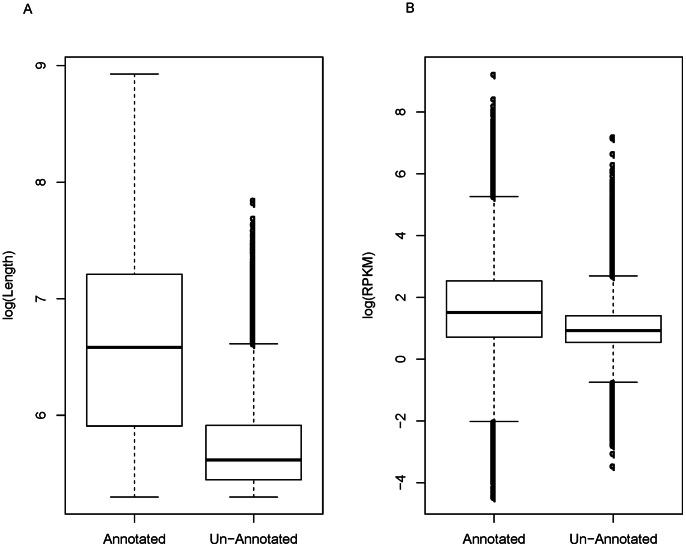
Boxplot distribution of unigenes in annotated and un-annotated unigenes.(A) Length distribution inferred with log(Length). (B) Expression level inferred by log(RPKM) value. Both show significant in ANOVA tests p = 2.2e-16.